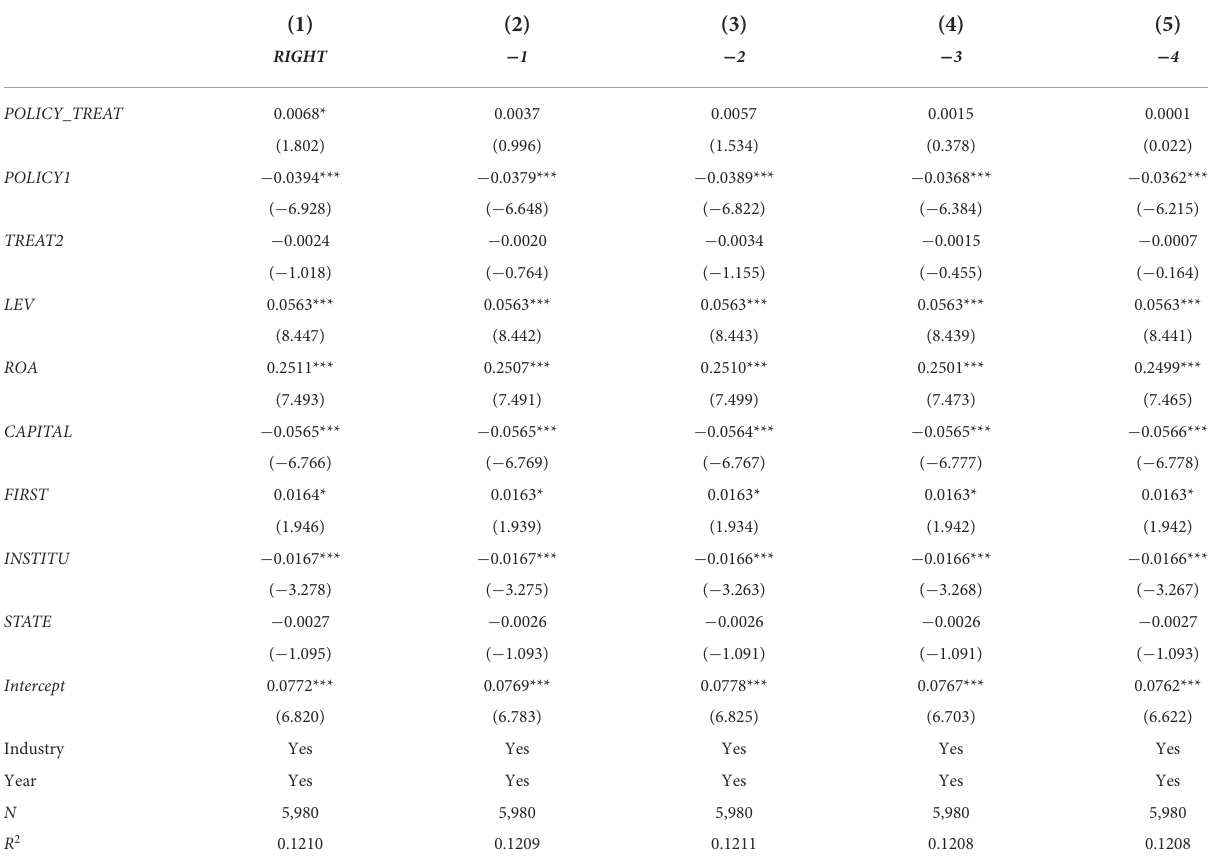
TABLE 9 Placebo test—pseudo year